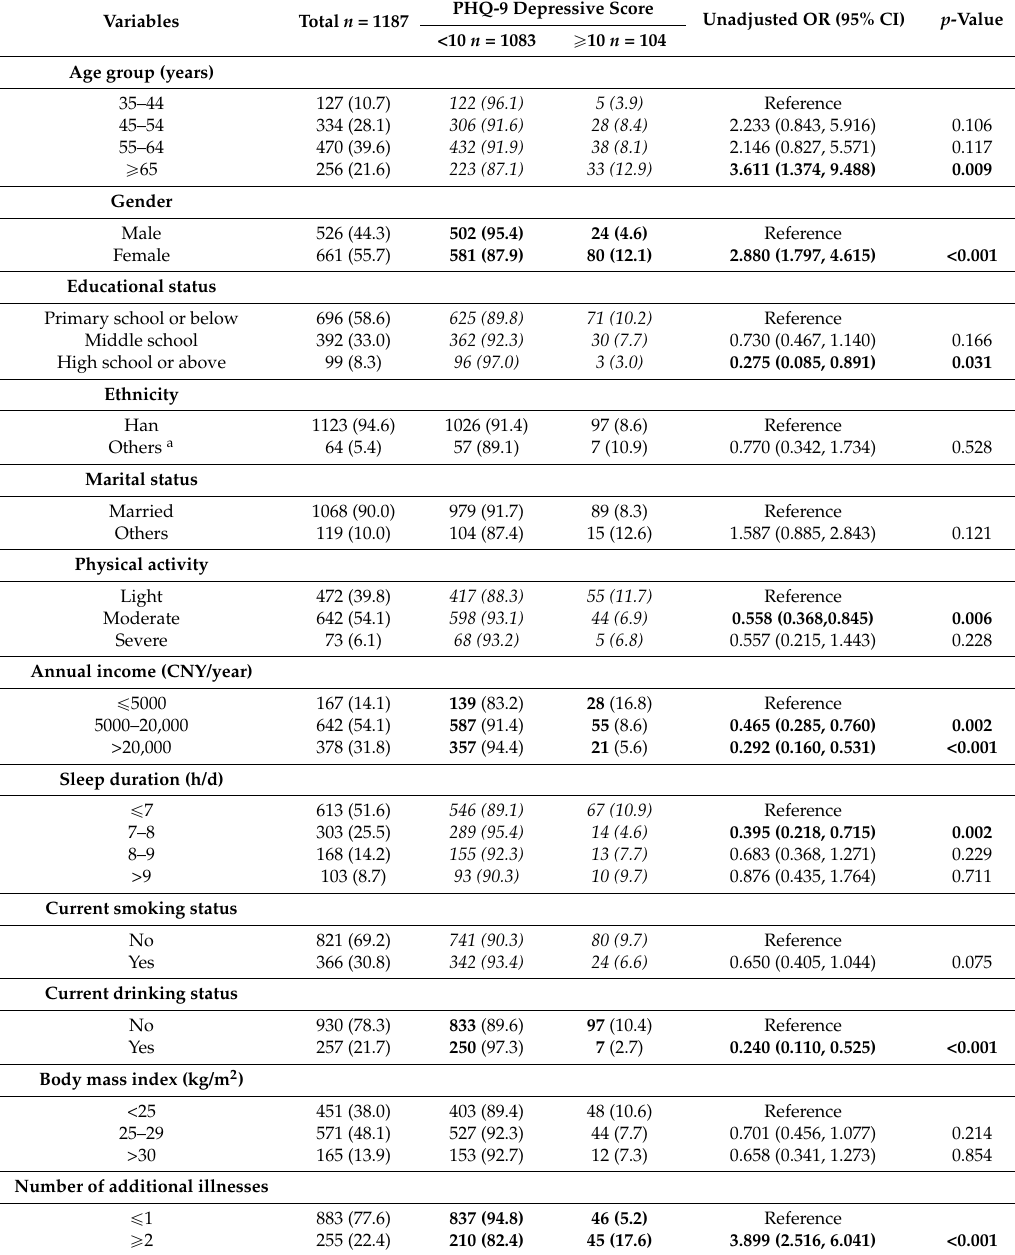
Table 1. Unvaried analysis of factors associated with depressive